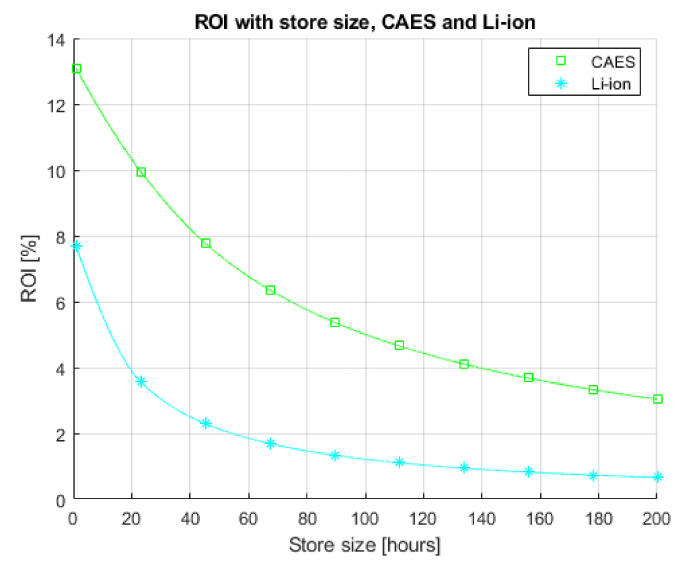
Figure 18. The relationship between one-year return on investment and storage capacity for the Li-ion and CAES